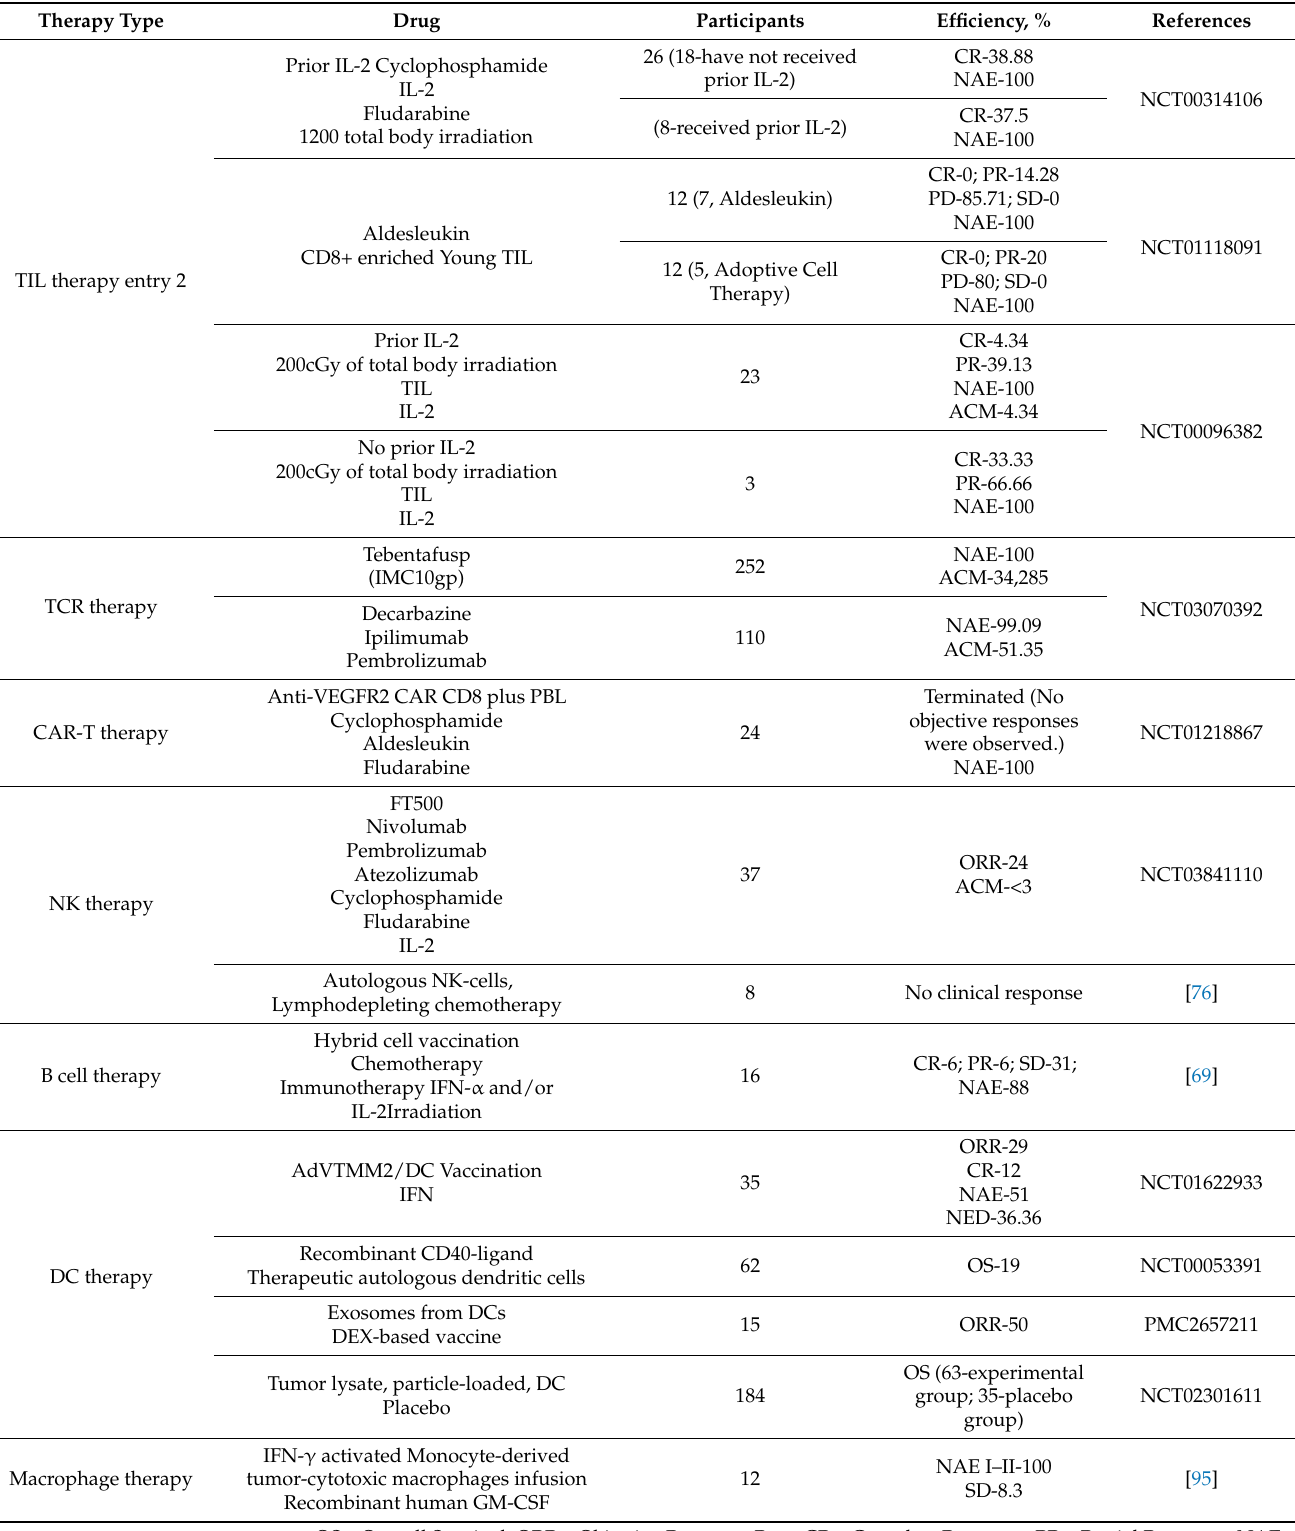
Table 1. Clinical results of single or combined cell-based in the treatment of